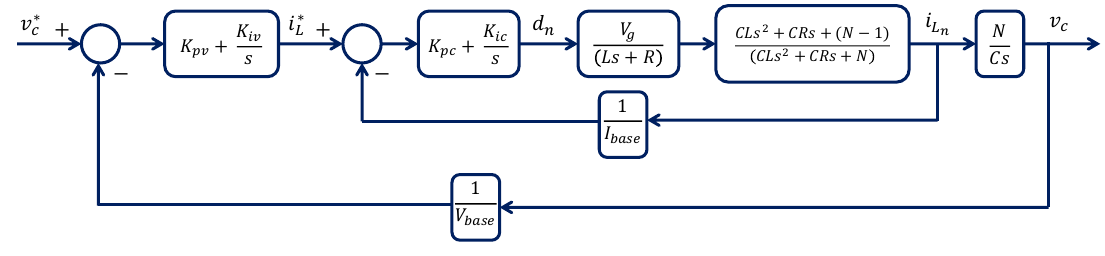
Figure 4. Linear closed-loop system.